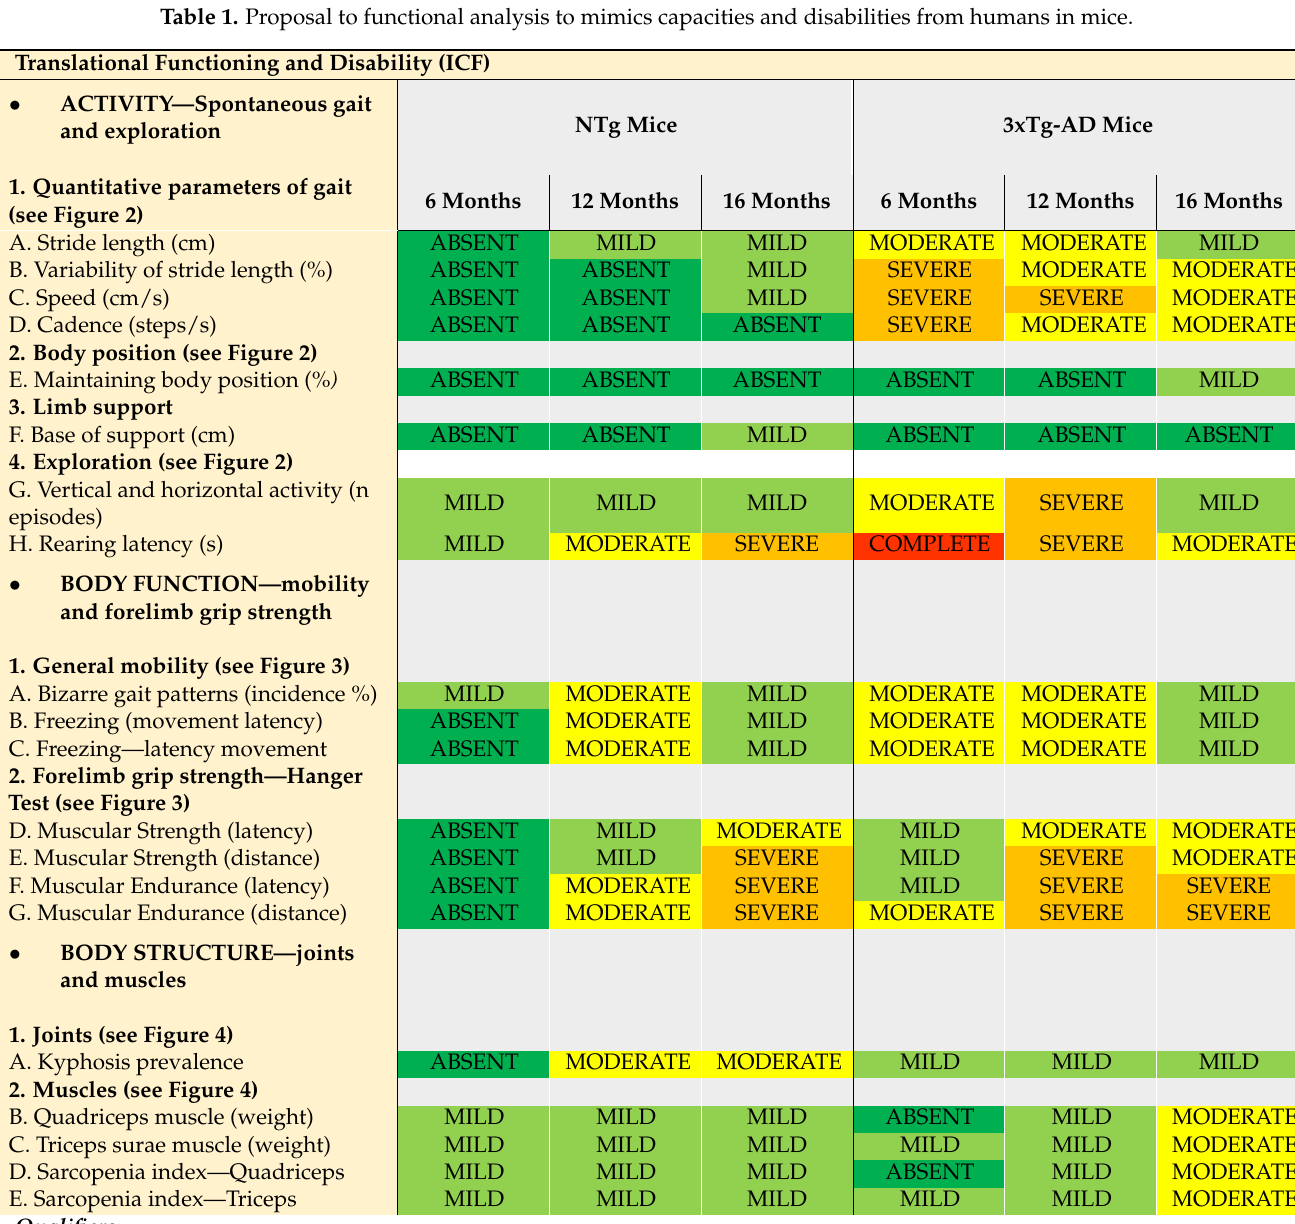
Table 1. Outcome measures that link gait and exploration impairments and limitations of male 3xTg-AD mice at different stages of AD progression to describe the functioning, according to qualifiers of ICF. Translational Functioning and Disability: ACTIVITY—spontaneous gait and exploration, BODY FUNCTION—mobility and forelimb grip strength, and BODY STRUCTURE—joints and muscles. Absent (green), Mild (light green), Moderate (yellow), Severe (orange), and Complete